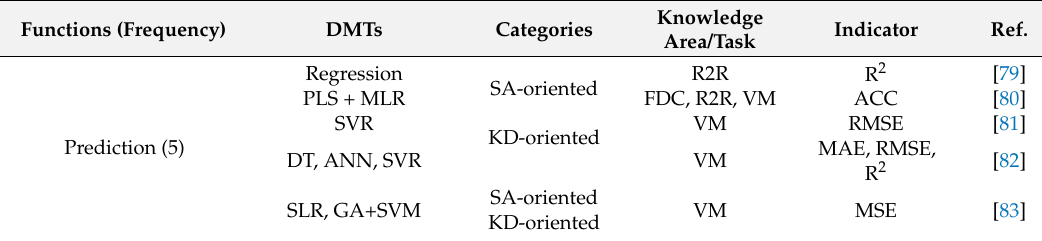
Table 11. DM with Big Data application for advanced equipment control/advanced process